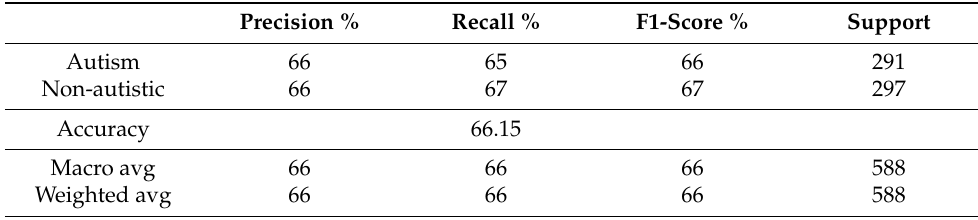
Table 6. Results of VGG-16 with decision